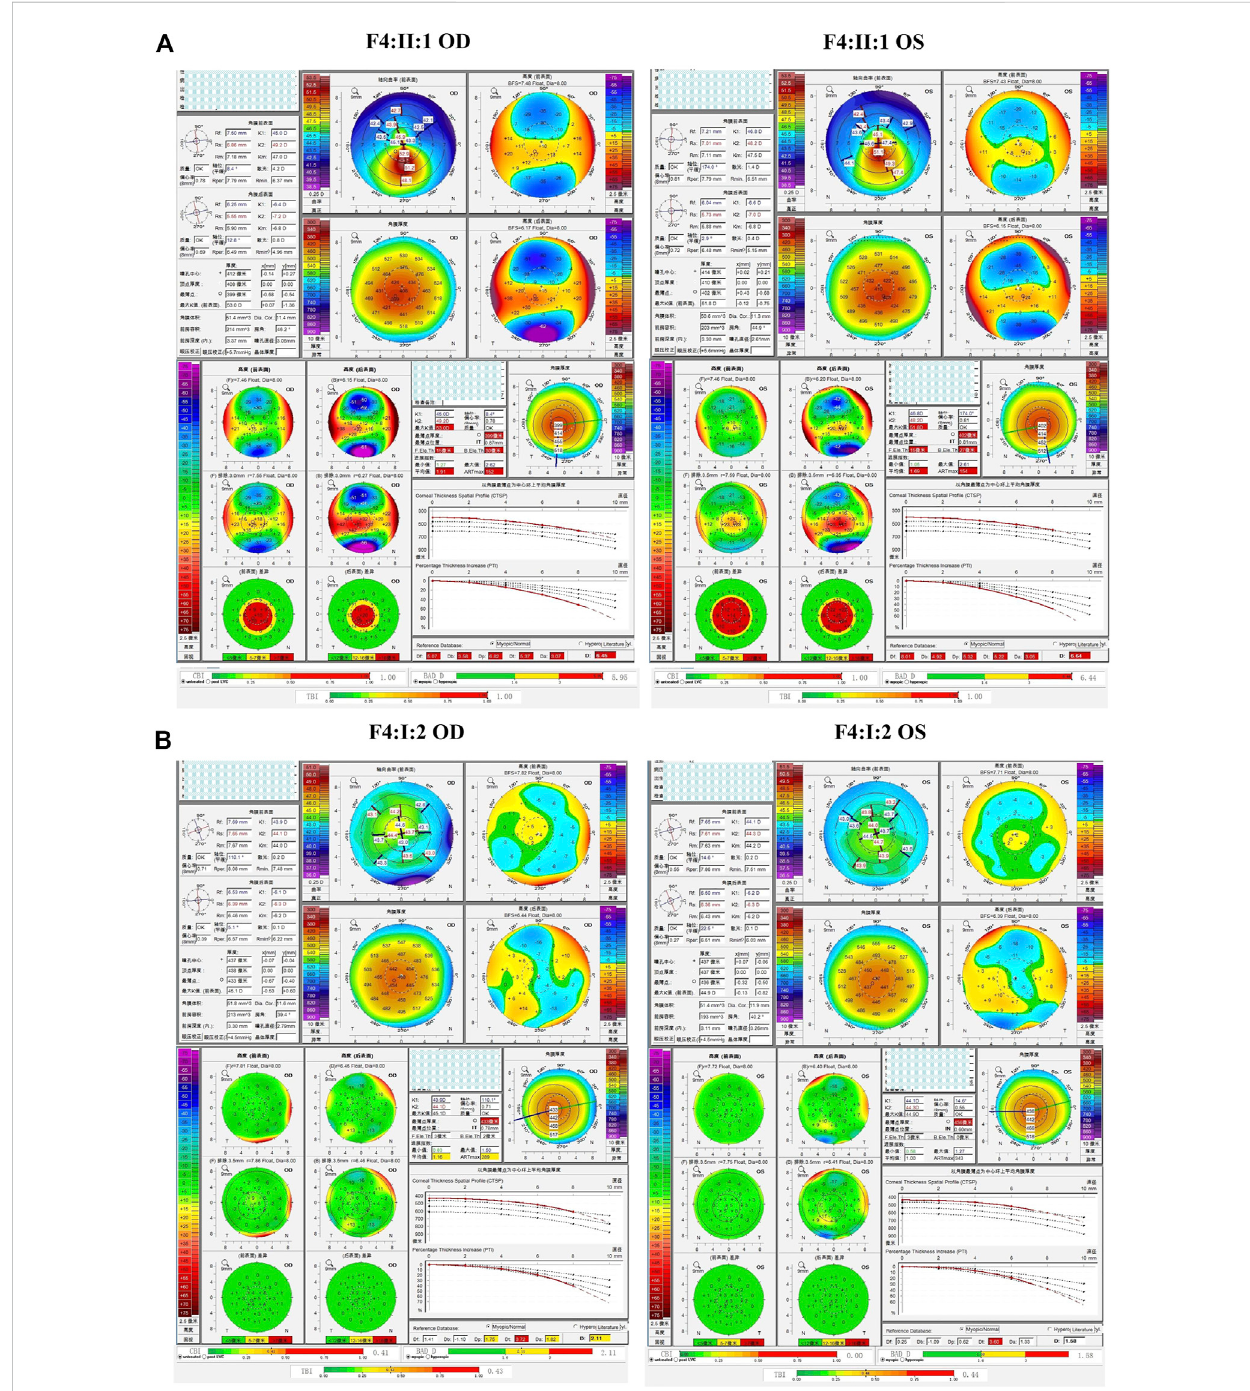
FIGURE 7 Pentacam and Corvis ST image of the proband and asymptomatic fi rst-degree relatives who carrying the variant p.R27R in family4. (A) Abnormal corneal topography and biomechanics of the proband. (B) Pentacam and Corvis ST examinations of the mother with the variant revealed six suspicious parameters (ARTmax, BAD-D, Dp, Da, CBI, and TBI) and two abnormal parameters (TP, and Dt) in the right eye, while one suspicious parameter (TBI) and two abnormal parameters (TP, and Dt) were detected in the left